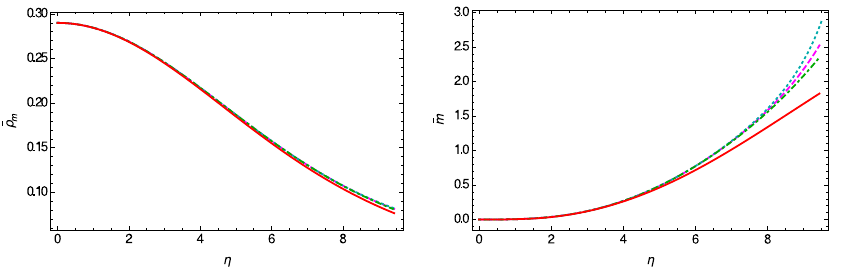
¯ b = − 0 . 11(dottedcurve),and ¯ b = 0 . 11(dot-dashedcurve).Thecentral density of the photon star is ρ mc = 7 . 12 × 10 14 g / cm 3 . The solid curve represents the standard general relativistic density and mass profiles for photon stars